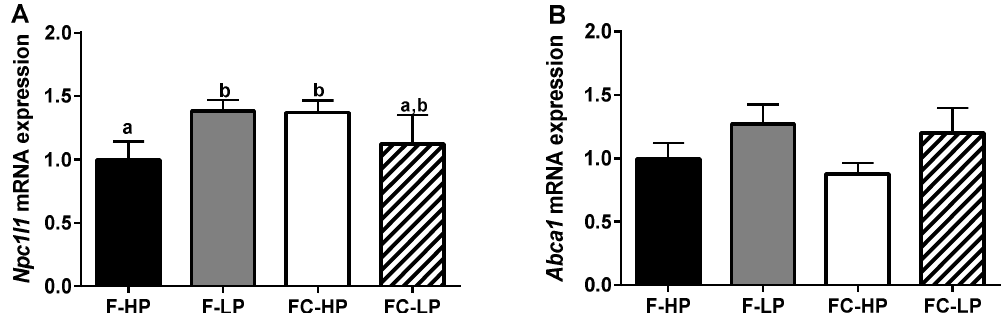
Figure 3. Npc1l1 ( A ) and Abca1 ( B ) mRNA fold change in ileal tissue of piglets fed different infant formulas containing high (F-HP) or low (F-LP) PS concentrations, supplemented with cholesterol (FC-HP, FC-LP) to achieve concentrations similar to human breast milk. Data are means ± SEM, n = 8/diet group. Statistical differences were determined by two-way ANOVA; for Npc1l1 mRNA, p = 0.653 for PS, p = 0.693 for cholesterol, and p = 0.037 for interaction; for Abca1 mRNA, p = 0.058 for PS, p = 0.512 for cholesterol, and p = 0.407 for interaction; Student Newman-Keuls post hoc analysis. Bars without a common letter significantly differ from each other, p < 0.05.